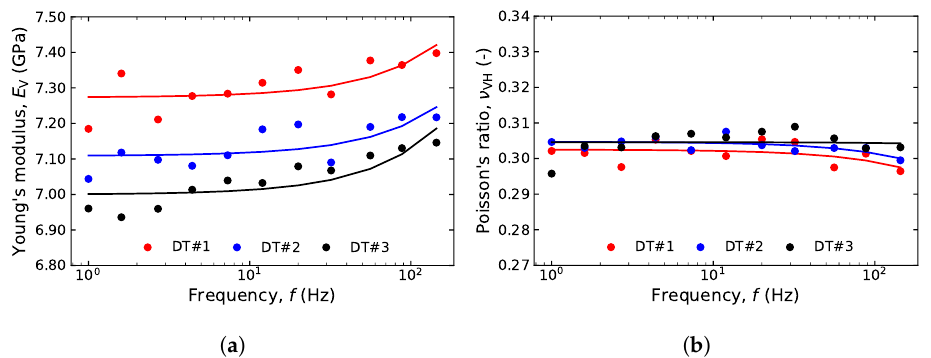
Figure 10. FO measured Young’s modulus E V ( a ) and Poisson’s ratio ν VH ( b ) versus frequency f with their respective regression lines at 43, 64, and 570 h corresponding to DT#1, DT#2, and